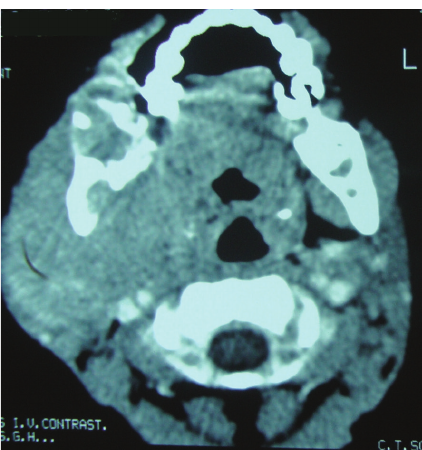
Figure 1: Computed tomography showing the extensions of the lesion.